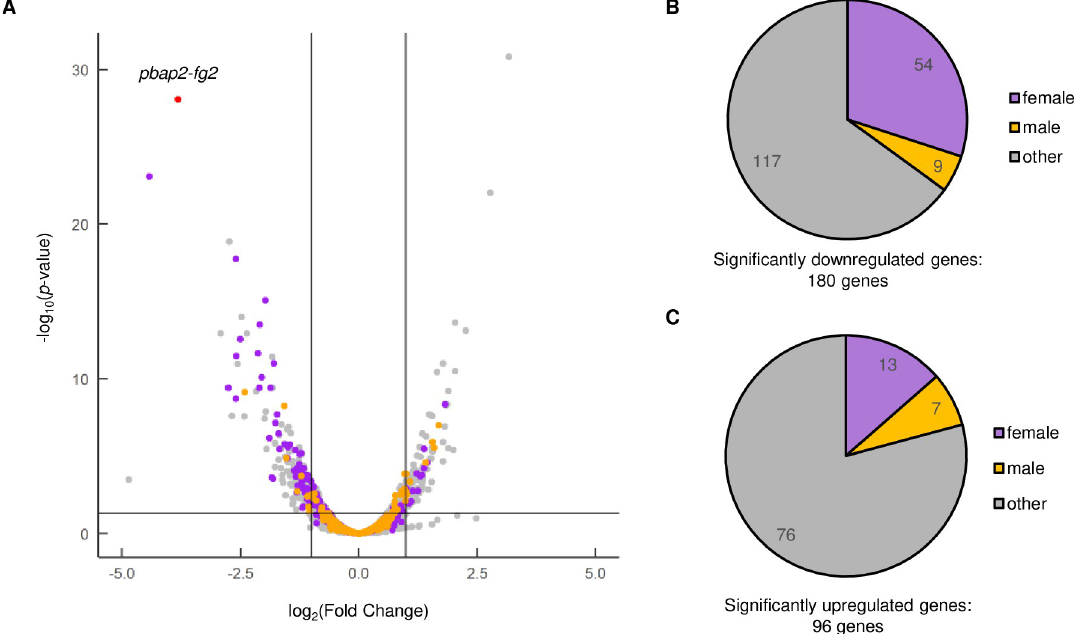
Fig 2. Differential expression analysis between WT and pbap2-fg2 (-). (A) A volcano plot showing differential expression of genes in pbap2-fg2 (-) compared to WT. Purple and orange dots represent female and male-enriched genes, respectively. A red dot indicates pbap2-fg2 . A horizontal line indicates p -value of 0.05, and two vertical lines indicate log 2 (Fold Change) of -1 and 1. (B) Classification of significantly downregulated genes into sexual stage-enriched gene sets. All genes not enriched in either “female” or “male” are classified as “other”. (C) Classification of significantly upregulated genes into sexual stage-enriched gene sets.